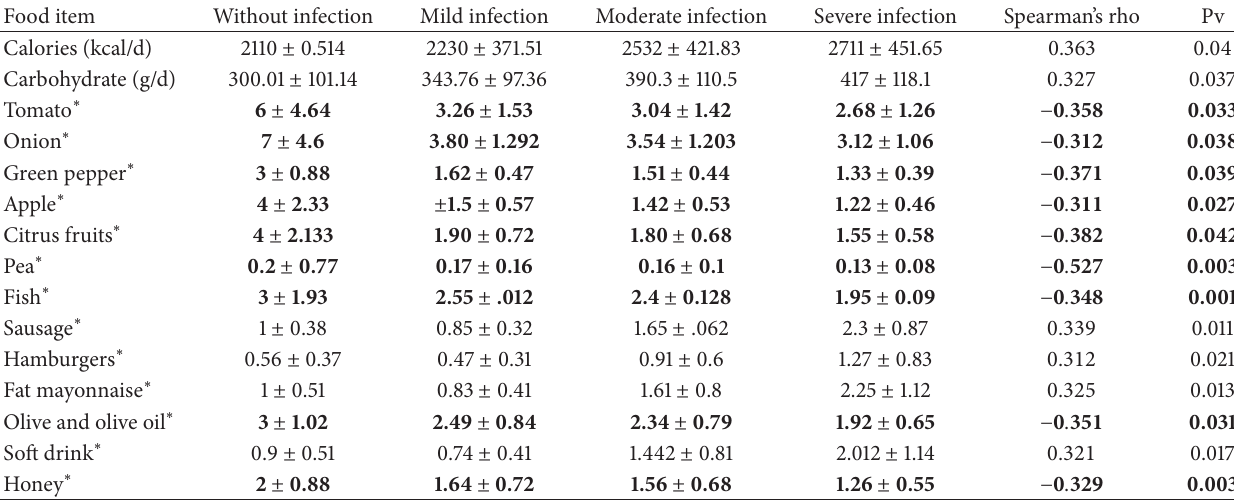
Table 5: Nutrient intakes of subject without infection and patients with different